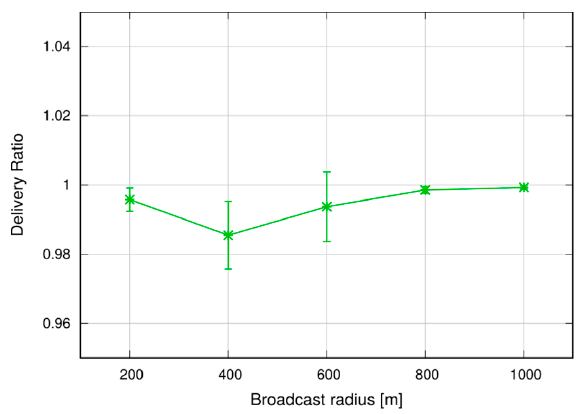
Figure 30. Average delivery ratio.